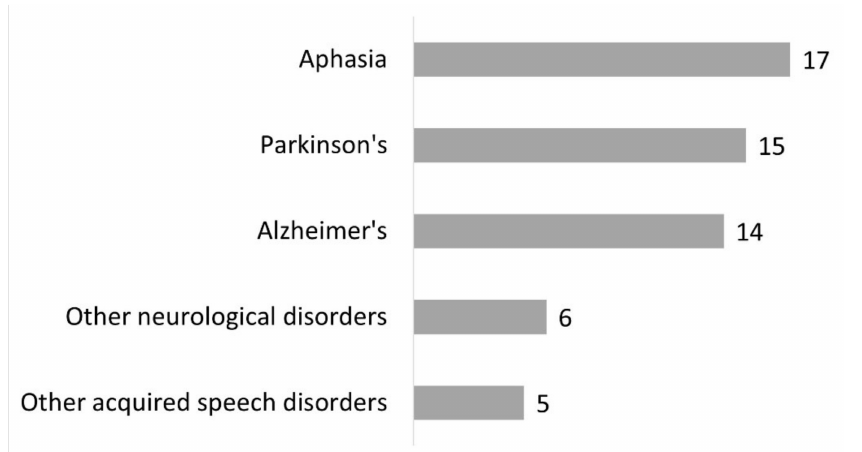
Figure 5. Reasons why participants did not refer patients to a choir (question #18 of the questionnaire, 157 respondents).